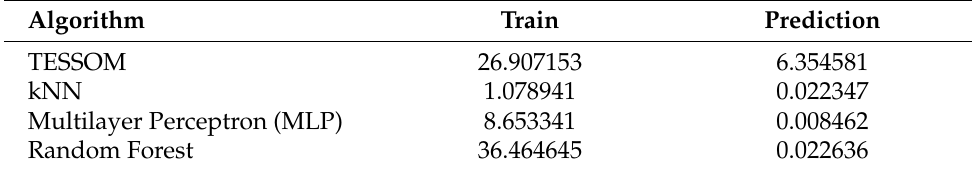
Table 7. Algorithms execution times